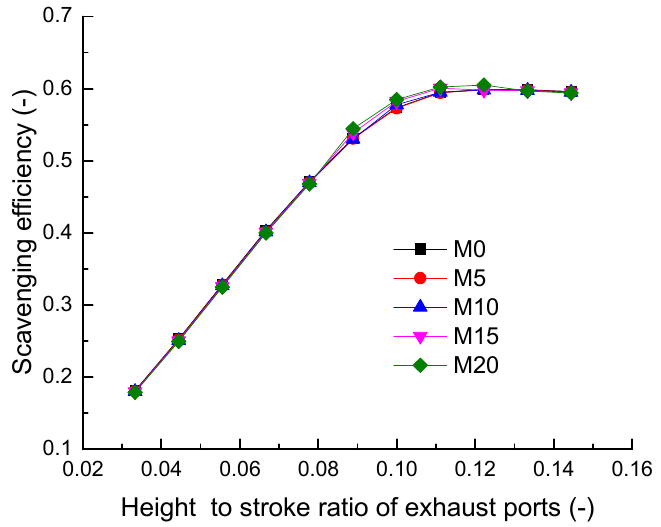
Figure 6. Scavenging efficiency for different height to stroke ratios of the exhaust